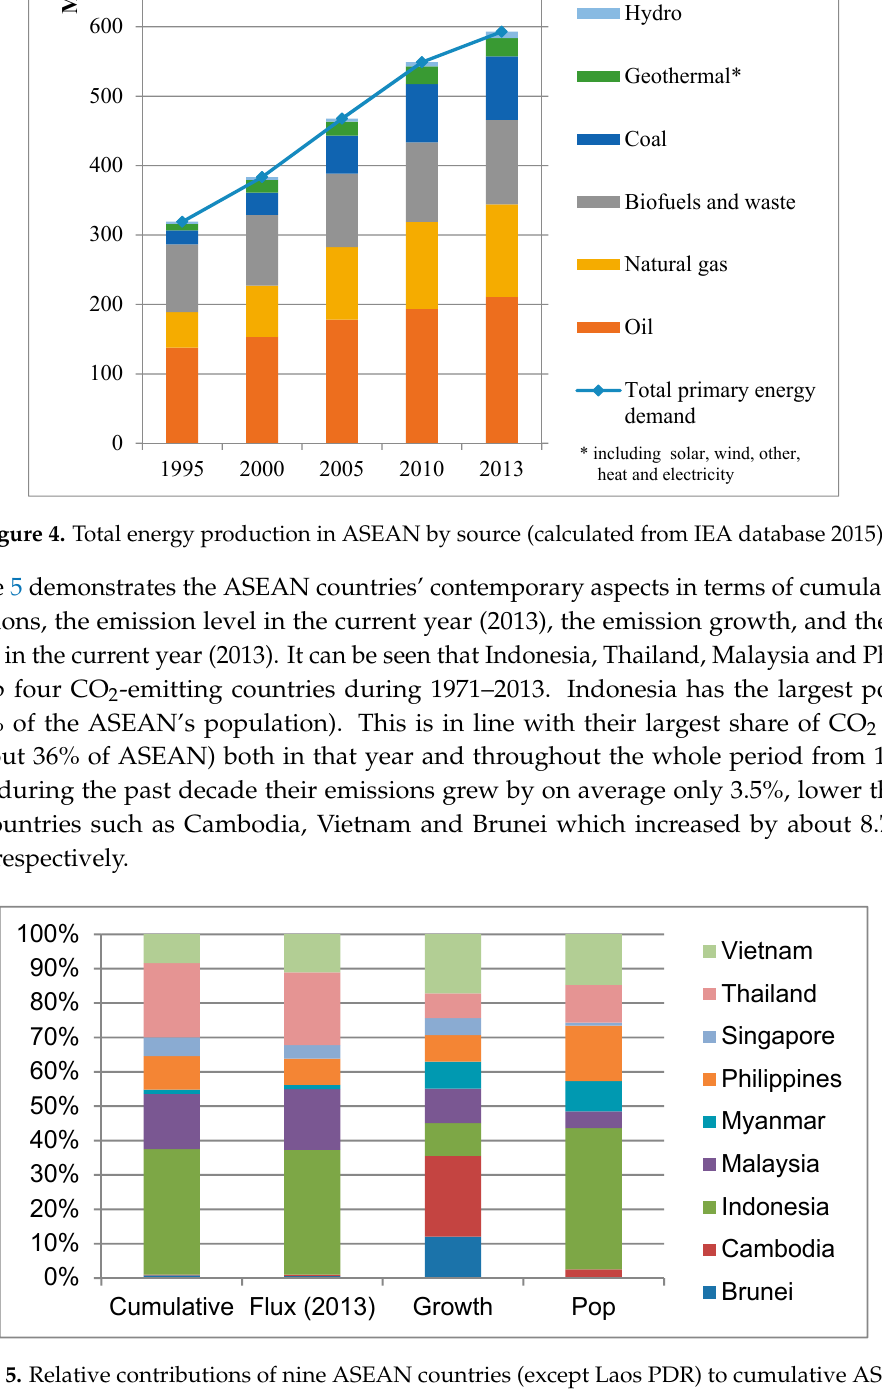
Figure 5. Relative contributions of nine ASEAN countries (except Laos PDR) to cumulative ASEAN